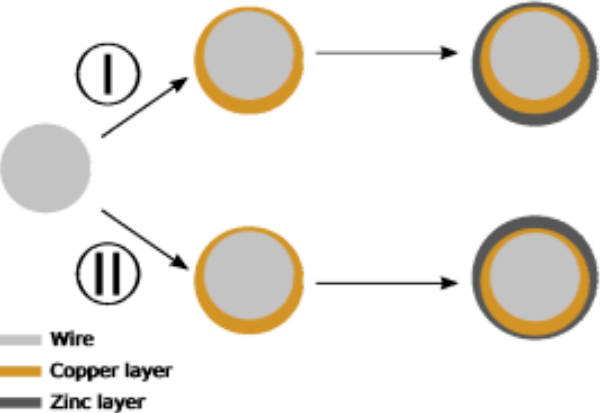
Figure 17. Diagram of deposition deviation in the case of horizontal positive plate. Reprinted with permission from ref. [28].